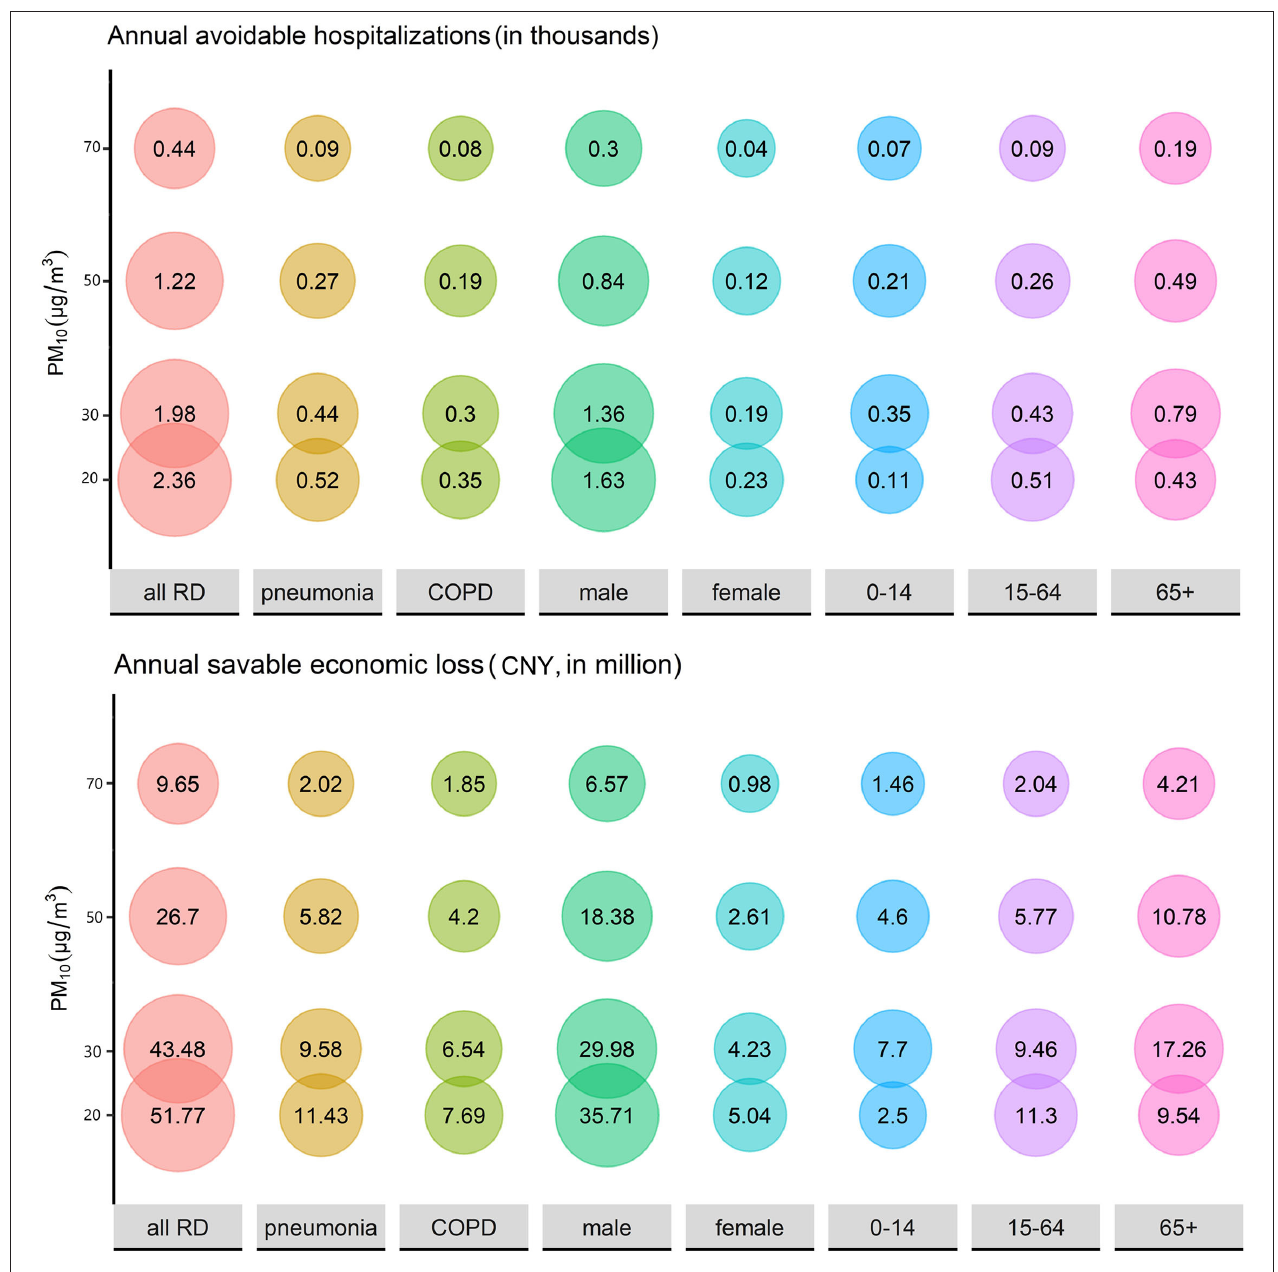
FIGURE 6 | The estimated annual avoidable hospitalizations and savable economic losses if the historical concentration of PM 10 could be maintained at relatively low levels.